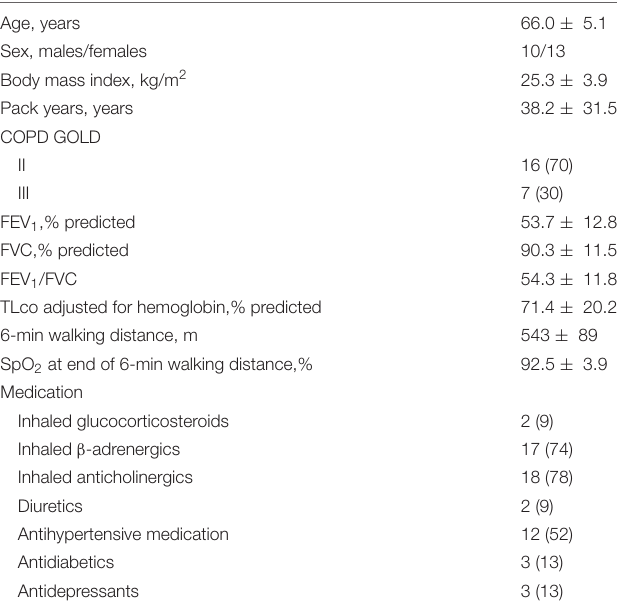
TABLE 1 | Baseline